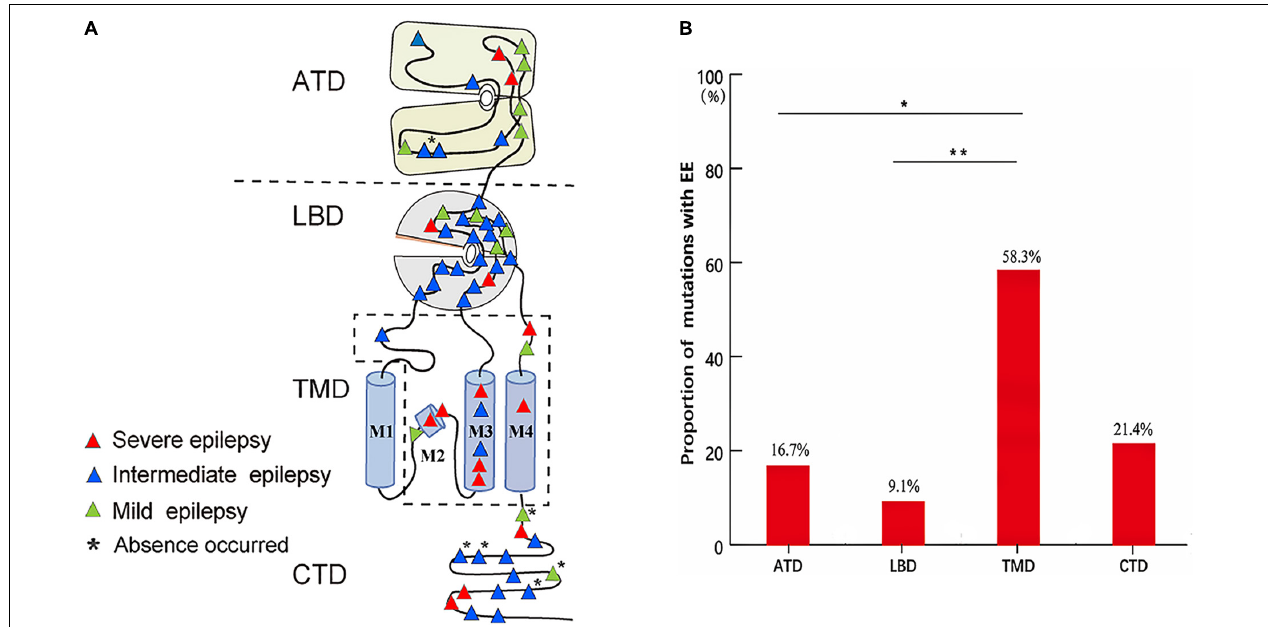
FIGURE 6 | The locations and corresponding phenotypes of epilepsy-related missense GRIN2A mutations. (A) Topological distribution of the GRIN2A missense mutations with different phenotypes. (B) The proportion of GRIN2A mutations with EE in different molecular regions. The proportion of missense mutations with EE around TMD was significantly higher than that in ATD and LBD (Pearson’s chi-square test, * p < 0.05; ** p < 0.01). ATD, amino terminal domain; LBD, ligand-binding domain; TMD, transmembrane domains; M1, M3, and M4, transmembrane domains; M2, re-entrant pore loop; CTD, carboxyl-terminal domain; EE, epileptic